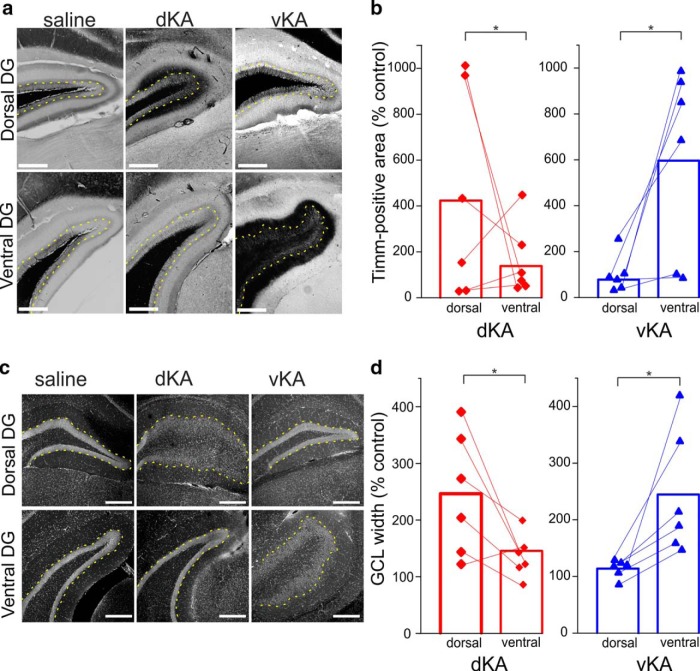
Similar anatomic pathologies maximally present near site of KA injection. a, Timm-stained images of the dentate gyrus (DG) of saline, dKA, and vKA animals near the area of dorsal and ventral targeting. Yellow dotted lines indicate the boundary of the granule cell layer and inner molecular layer. Scale bar, 300 µm. b, Comparison of Timm-positive granule cell and molecular layer area, normalized to saline controls, between dorsal and ventral hippocampal locations for dKA and vKA groups (dKA, n = 6 animals; vKA, n = 6 animals). c, DAPI-stained images of dentate gyri from saline, dKA, and vKA animals. Yellow dotted lines indicate the boundary of the granule cell layer and inner molecular layer. Scale bar, 300 µm. d, Comparison of granule cell layer width, normalized to saline controls, at dorsal and ventral locations for dKA and vKA animals (dKA, n = 6 animals; vKA, n = 6 animals). *p < 0.05. Dorsal location, ∼1.8 mm past bregma; ventral location, ∼3.4 mm posterior to bregma. Red bar and data points reflect dKA data; blue bar and data points reflect vKA data.